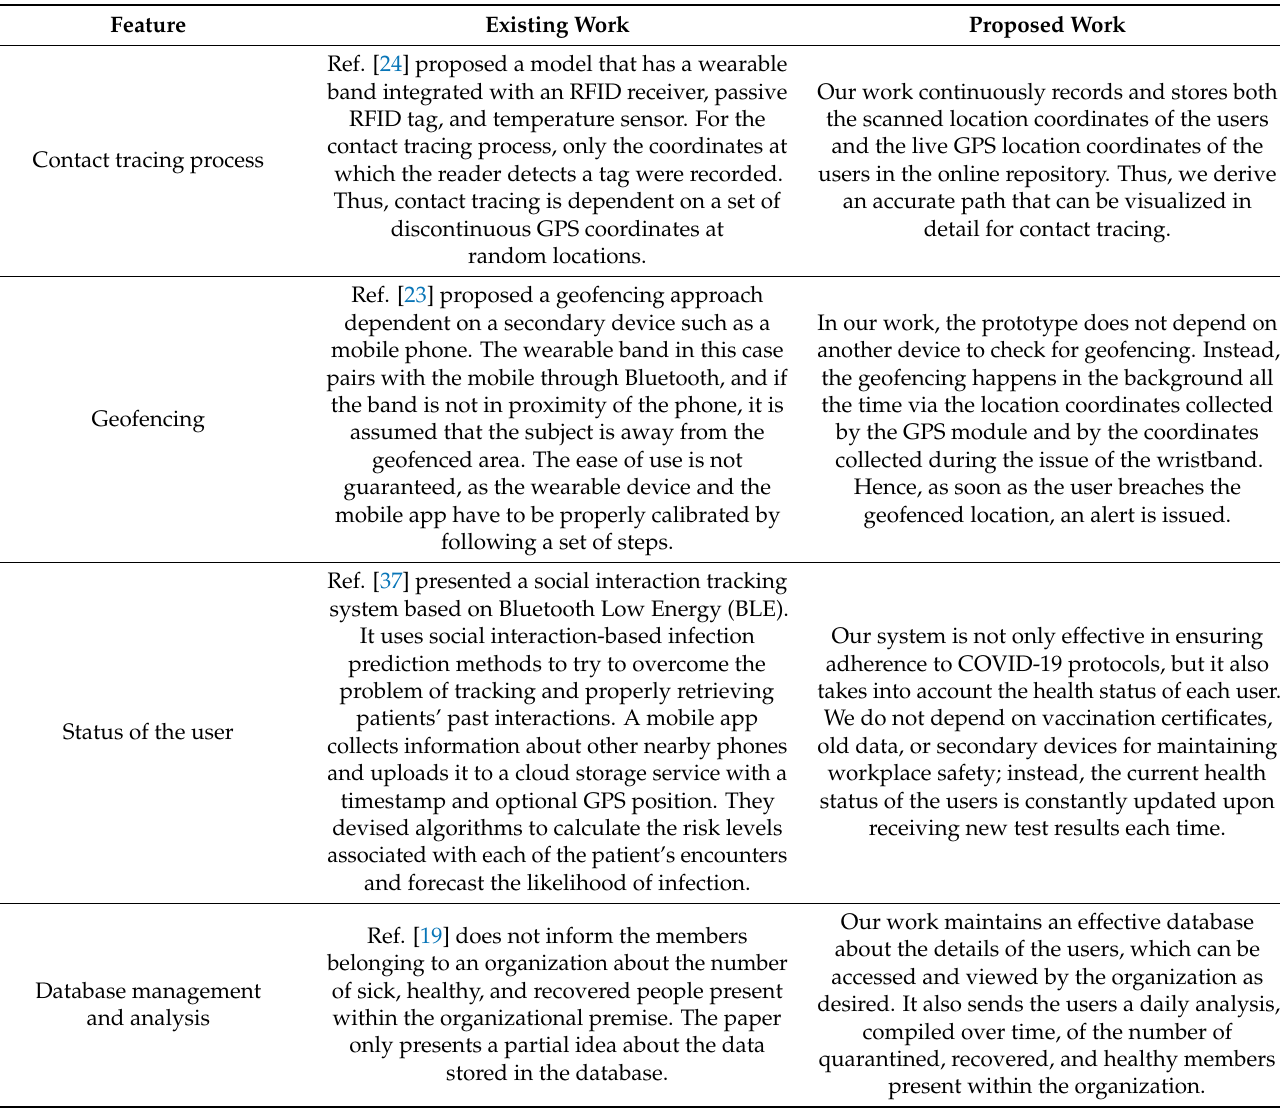
Table 2. Comparison of our proposed work with the existing